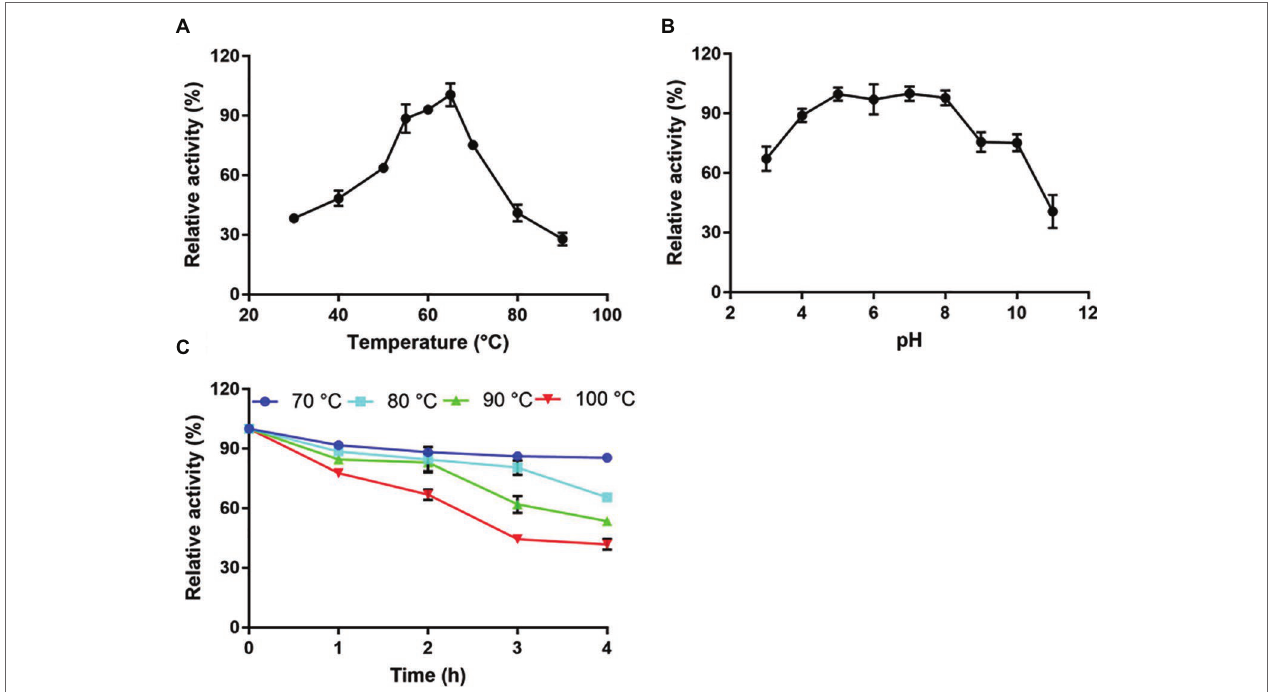
FIGURE 3 | Characterization of CMC-Na hydrolysis by purified Tk-ChiA. (A) Influence of temperature on Tk-ChiA activity. Enzyme activity levels at various temperatures were assayed at pH 7.0 for 1 h using CMC-Na as the substrate. Values obtained at 65 ° C were set as 100%. (B) Effect of pH on Tk-ChiA activity. Enzyme activity levels at various pH values were assayed at 65 ° C for 1 h using CMC-Na as the substrate. Values obtained at pH 7.0 were set as 100%. (C) Thermostability of Tk-ChiA. Residual activity was assayed using CMC-Na as the substrates after pre-incubation without a substrate at 70 ° C (circle), 80 ° C (square), 90 ° C (triangle), and 100 ° C (inverted triangle) for different periods of time.